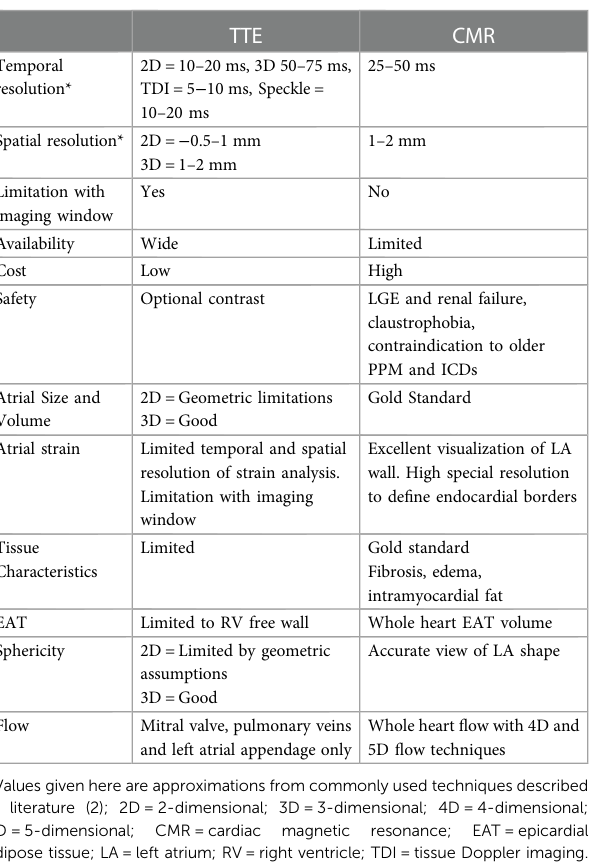
TABLE 1 Comparison of TTE and CMR for evaluation of atrial structure and function. TTE CMR